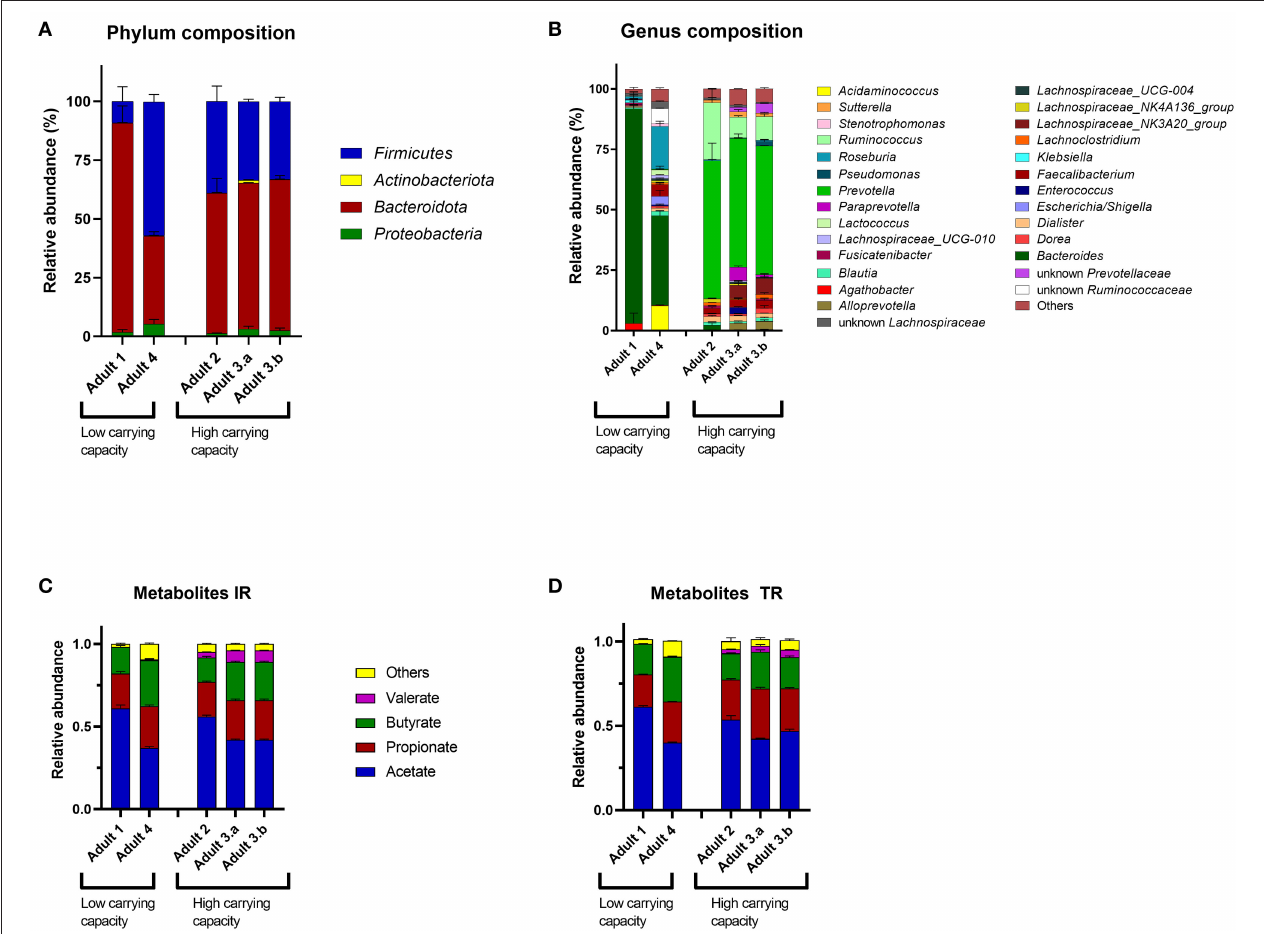
FIGURE 5 | Microbiota composition and metabolite profile of different in vitro adult colonic microbiota. Relative abundance based on analysis of the 16S rRNA gene sequencing at (A) phylum and (B) genus level of 3 consecutive days of IRs containing colonic microbiota of donor 1 to 4. Values at genus level < 1% are summarized in “Others.” The metabolic profile was analyzed in the (C) IR and the (D) corresponding TR for 3 consecutive days. The metabolites succinate, lactate, formate, iso-butyrate, and iso-valerate are summarized in “Others.” High carrying capacity indicates 10 5 and low between 10 3 and 10 4 CFU L. plantarum /ml